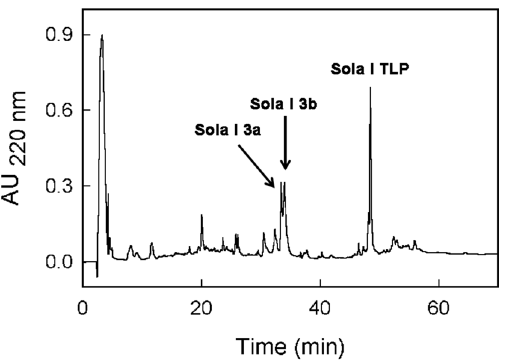
Figure 4. RP-HPLC profile of the fraction enriched in basic proteins obtained from mature (red) fruit of the control sample ‘Standard’. The peaks were manually collected and Sola l 3a, Sola l 3b and TLP were identified by N-terminal amino acid sequencing.